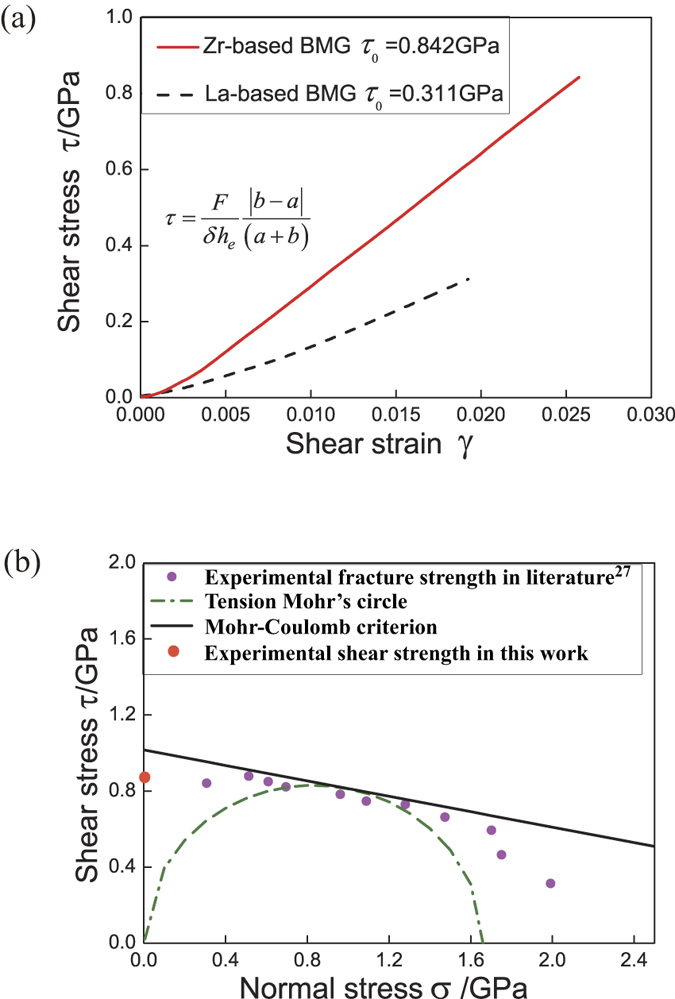
(a) Pure shear stress-strain curves for Zr-based and La-based BMGs. Shear stress τ is calculated by the inserted equation. (b) Comparison of the shear fracture strength between the experimental and calculated results by Morh-Coulomb criterion for Zr52.5Cu17.9Ni14.6Al10Ti5.